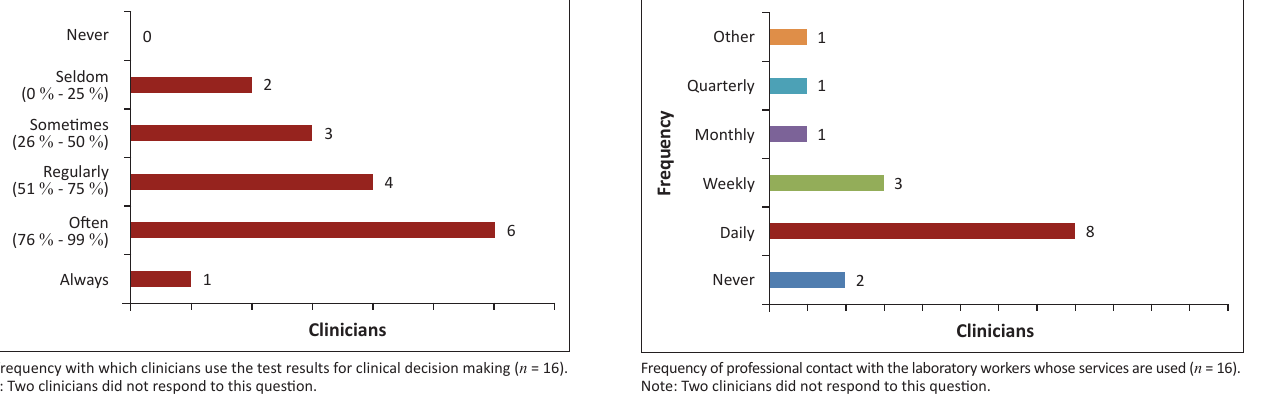
FIGURE 3: Professional factors. The perceptions of clinicians regarding the frequency with which test results are used for making clinical decisions.